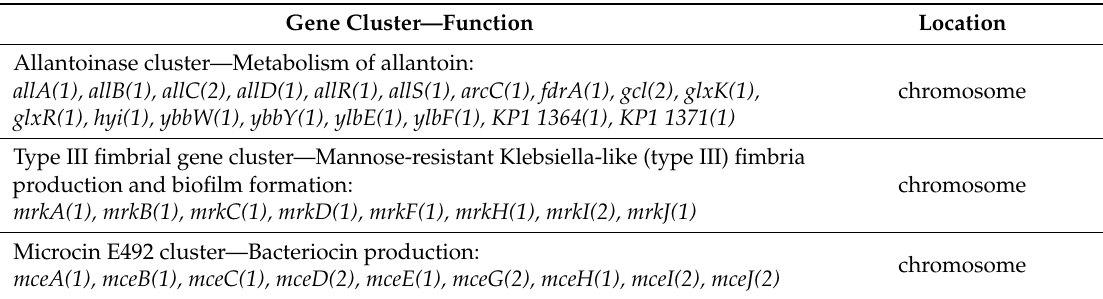
Table 3. Virulence and heavy metal resistance-associated genes of